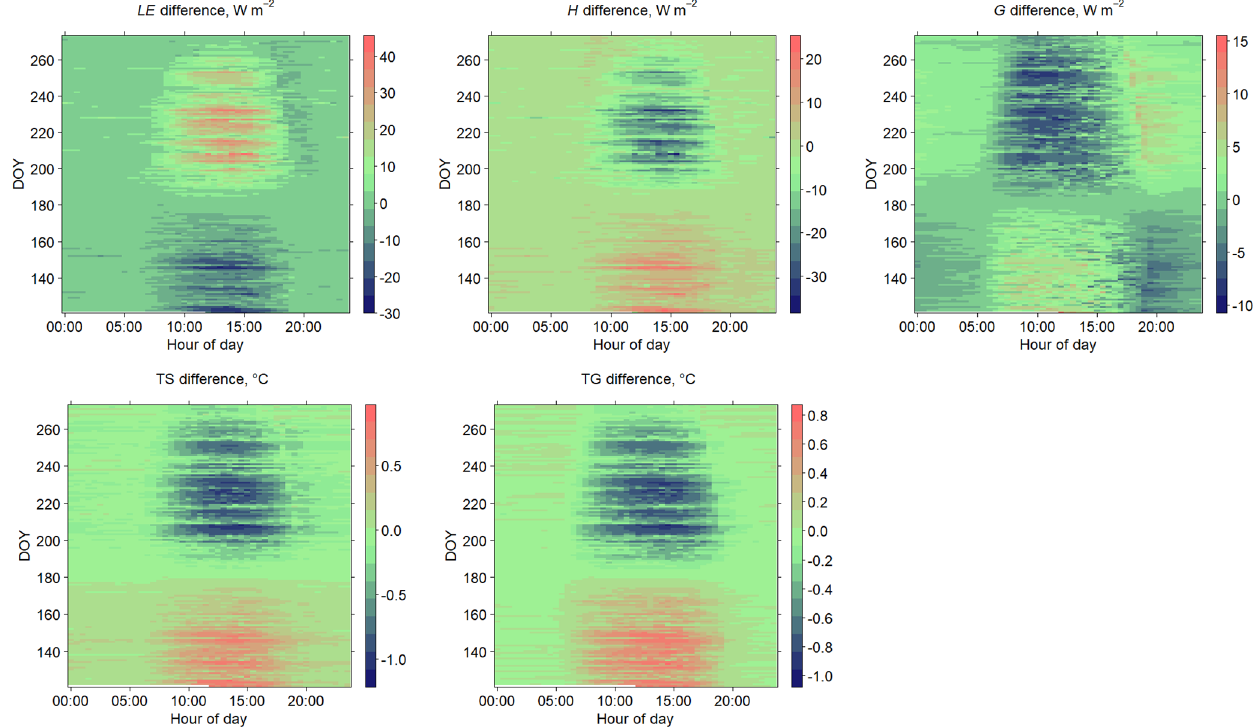
Figure 8. Impact of increasing the LCC fraction from 28% to 38% on latent heat flux ( LE ), sensible heat flux ( H ), ground heat flux ( G ), surface temperature (TS) and ground temperature (TG) (increased LCC share minus baseline simulation). Time is local